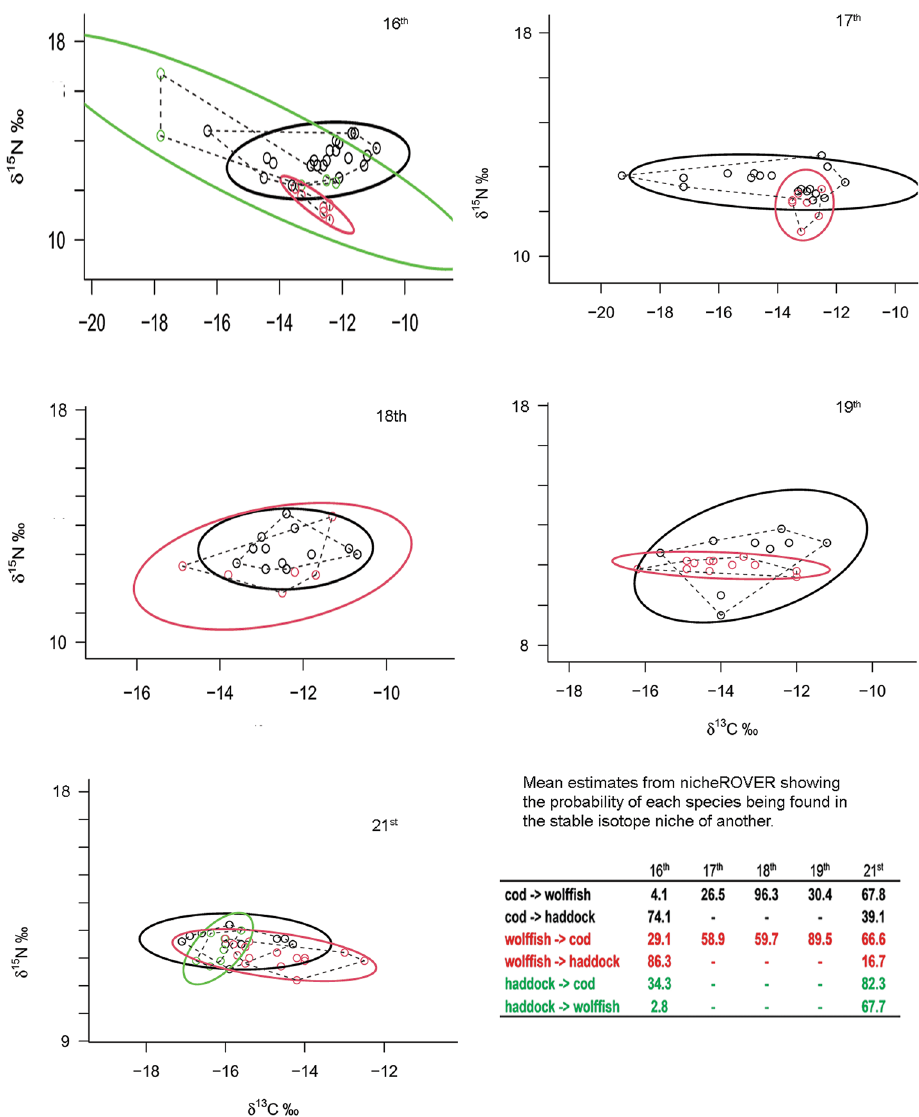
Figure 5. δ 13 C and δ 15 N values and standard ellipses of demersal fish for the centuries were five or more samples of two or more species were available. Atlantic cod and wolffish in the four temporal groups were samples for both species were available. Black ellipses show Atlantic cod, red ellipses are wolffish and green ellipses are haddock. The insert text shows the likelihood of each species being observed in the isotope niche of the others as estimated by nicheROVER (see “Materials and methods”) with the direction of the effect indicated by an